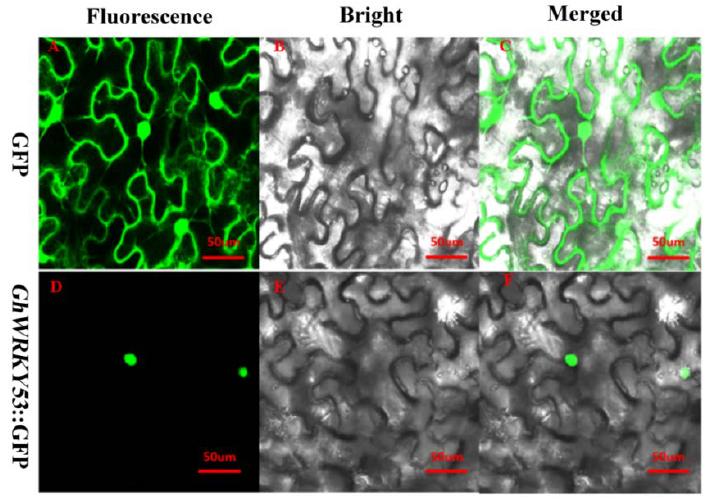
Figure 8. Subcellular localization of GhWRKY53 . ( A – C ) Subcellular localization in tobacco leave cell, which was agroinfiltrated with pRI101-GFP vector. Fluorescence was observed in the whole cell, showing nucleus and membrane localization of GFP. ( D – F ) Subcellular localization in tobacco leave’s cell, which was agroinfiltrated with GhWRKY53 -pRI101-GFP vector. Fluorescence was observed only in the nucleus, showing nuclear localization of GhWRKY53 -GFP. Scale bar, 50 µ